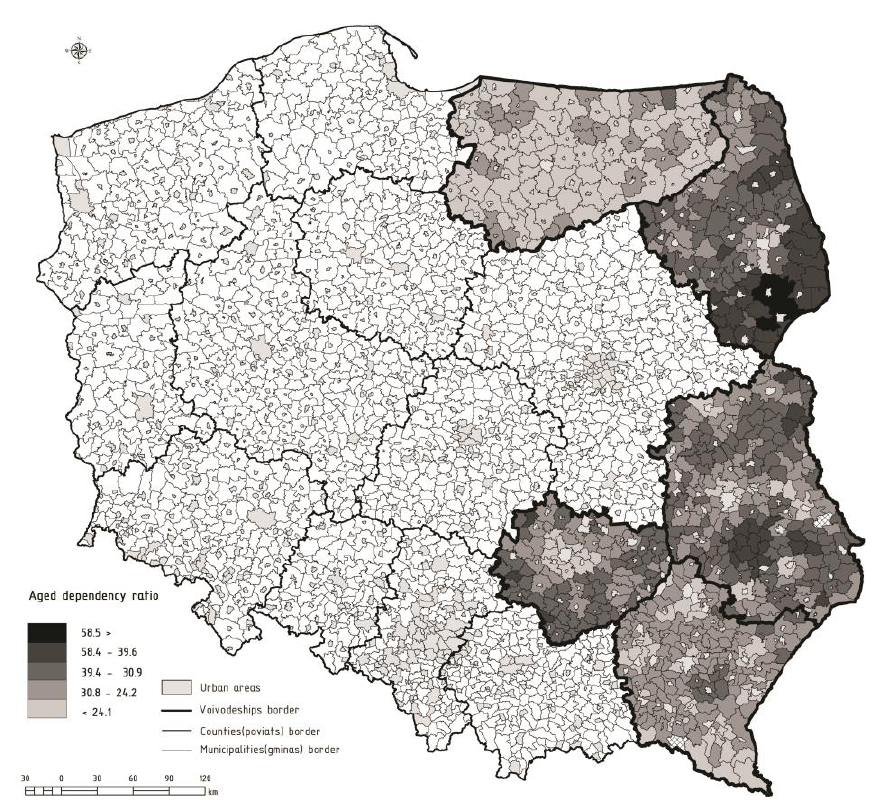
Fig. 7. Post-working age population per 100 persons of working age in rural areas of Eastern Poland in 2008 (Source: calculations of the authors)